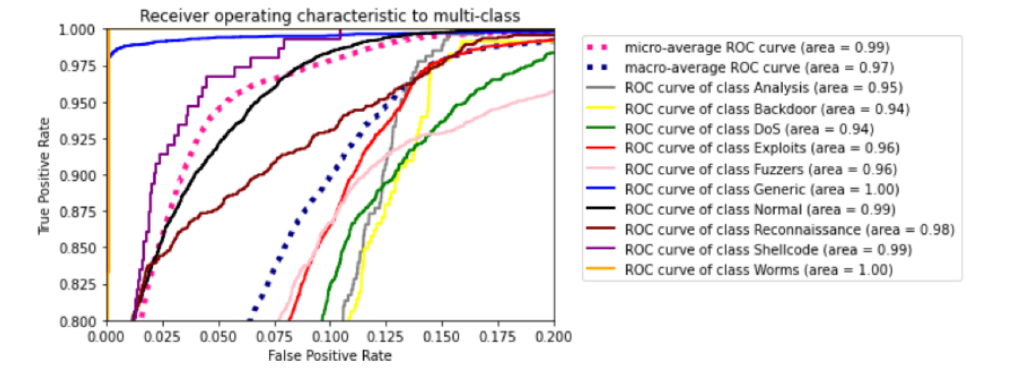
Figure 6. ROC curve.